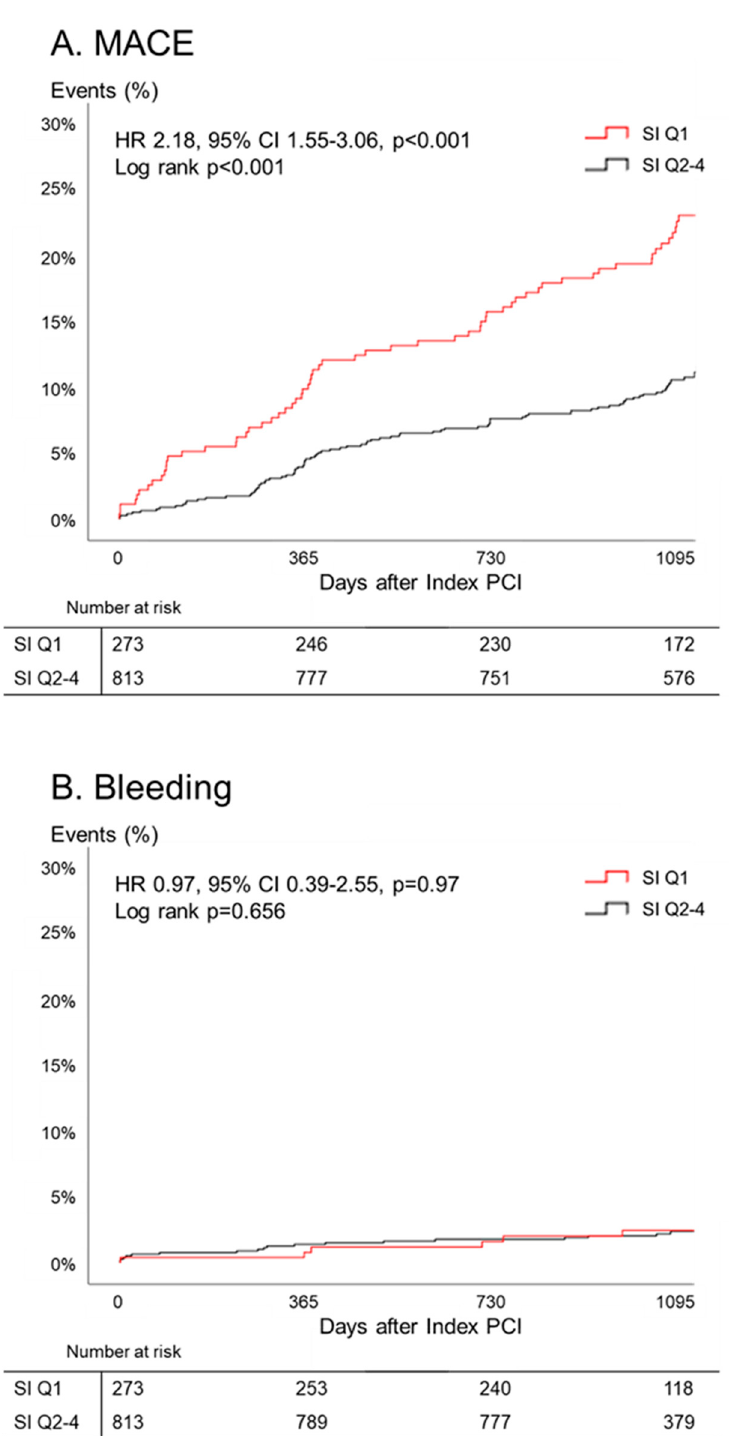
Figure 3. Cumulative incidence of events with quartiles of sarcopenia index. Overall, the lowest quartile group had a higher major advance cardiovascular event (MACE) rate, while there were no significant differences in bleeding events. SI = sarcopenia index; MACE = major advance cardiovascular event; PCI = percutaneous coronary intervention; HR = hazard ratio; CI = confidence interval.